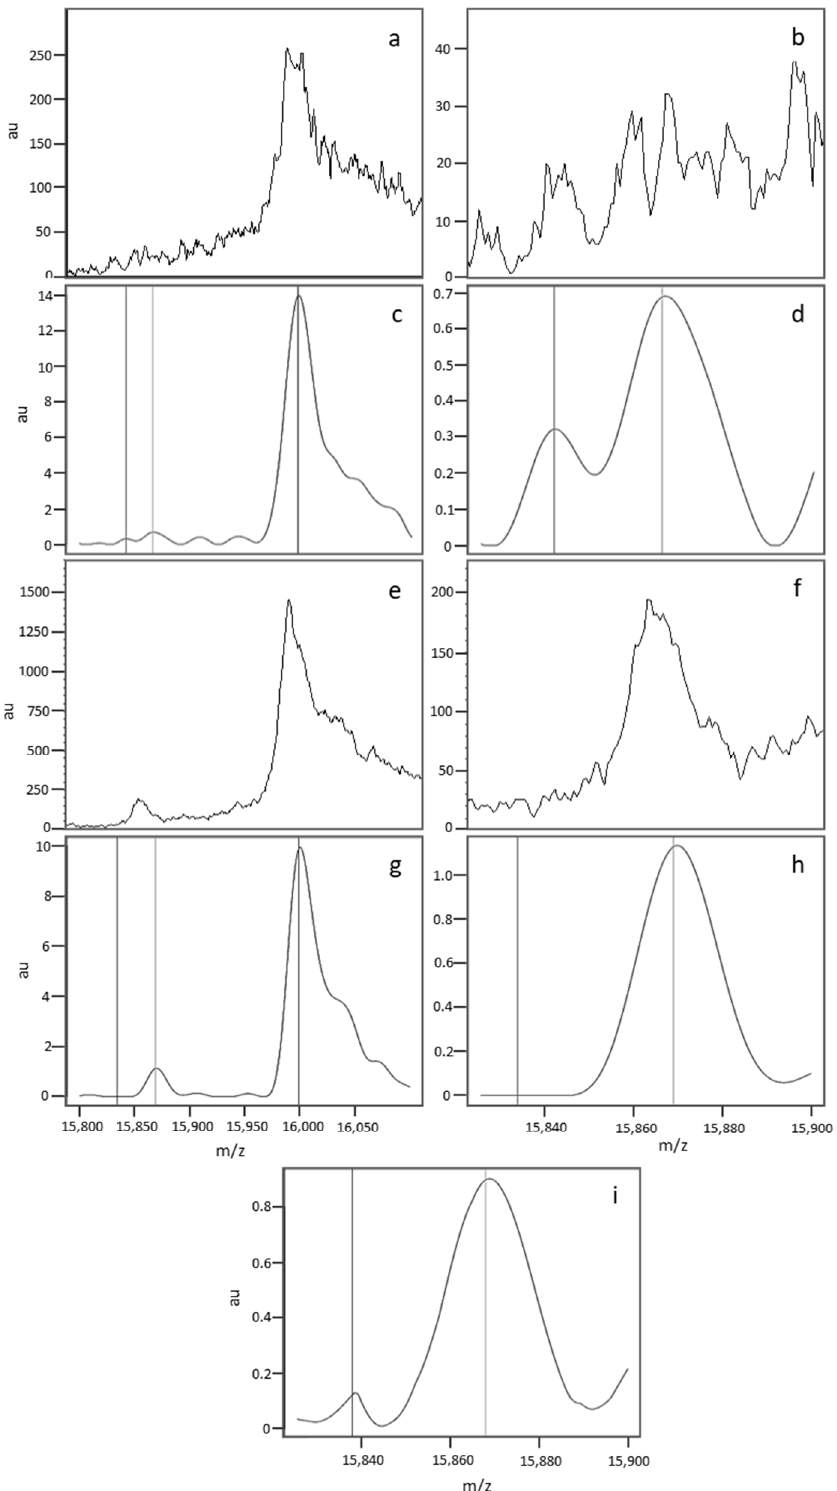
Figure 4. The spectra in ( a , b , e , f ) correspond to the raw data generated for the first ( a , b ) and third ( e , f ) of the quadruplicate depositions from the same sample. ( a , c , e , g ) show the whole spectrum (15,800–16,100 Da), and ( b – f , h , i ) show the region of interest (15,820–15,900 Da). The spectra in ( c – h correspond to the processed spectra after alignment, baseline subtraction, and normalisation. The median spectrum ( i ) was obtained by compiling the individual normalized spectra.